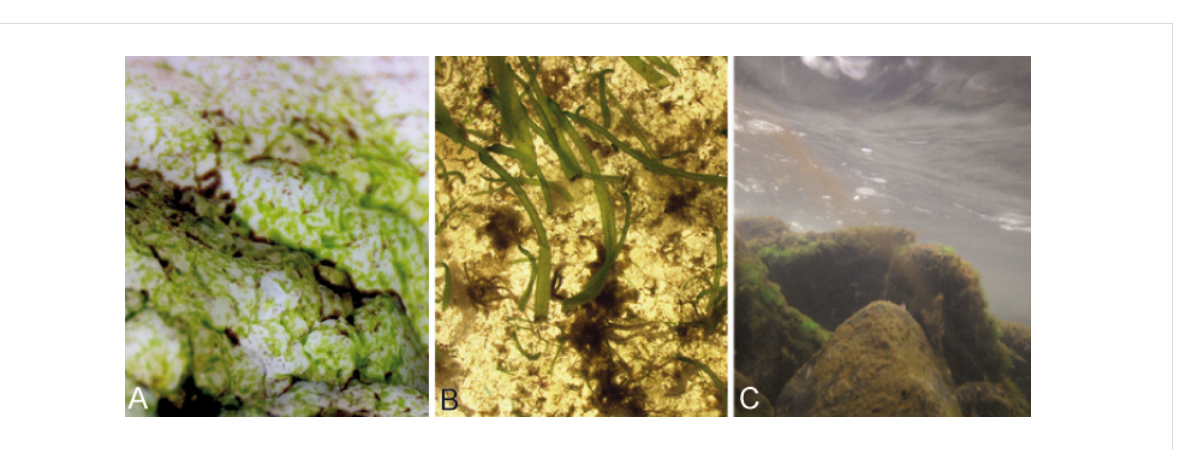
Figure 3: Examples of substrates which have been exposed to an aquatic environment and are covered with biofilm and periphyton; A) stone of the marine intertidal covered with biofilm and algae (image: Petra Ditsche); B) artificial substrates after 6 week exposure in the sea, with biofilm and growth of first macroalgae (image: Adam Summers); C) biofilm and macroalgae cover the stones of this stream in a thick layer (image: Sarah